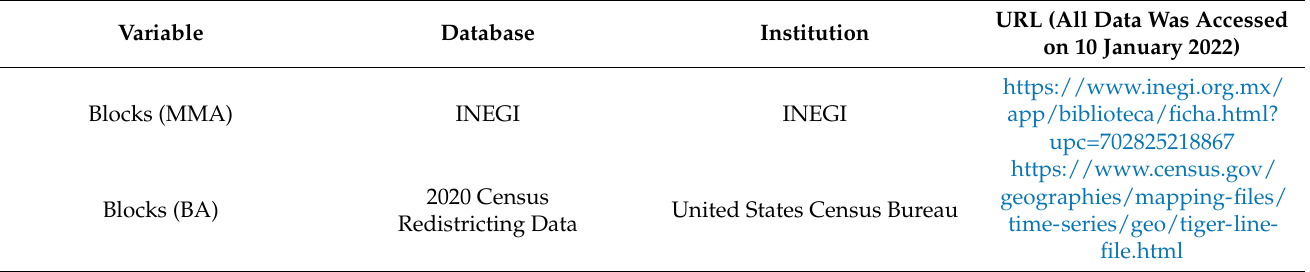
Table 3. Urban blocks’ datasets used for the computation of urban accessibility in this